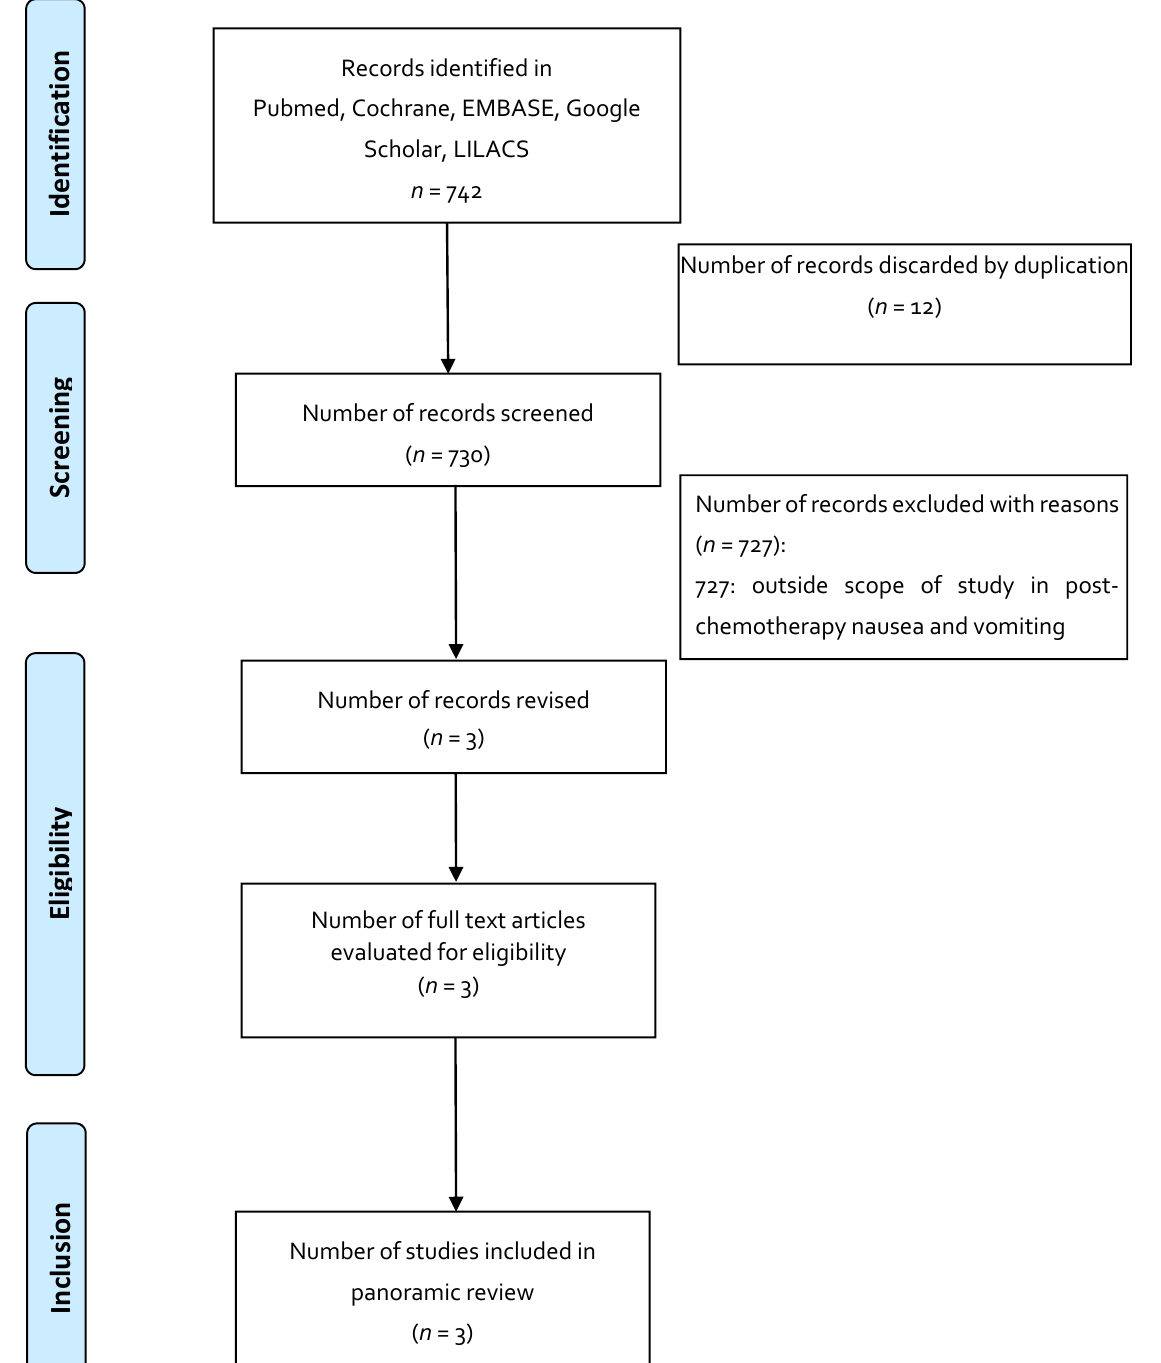
Figure 1. Flowchart depicting the selection process for the studies included in the paper: indication in anorexia and ca- chexia in HIV.